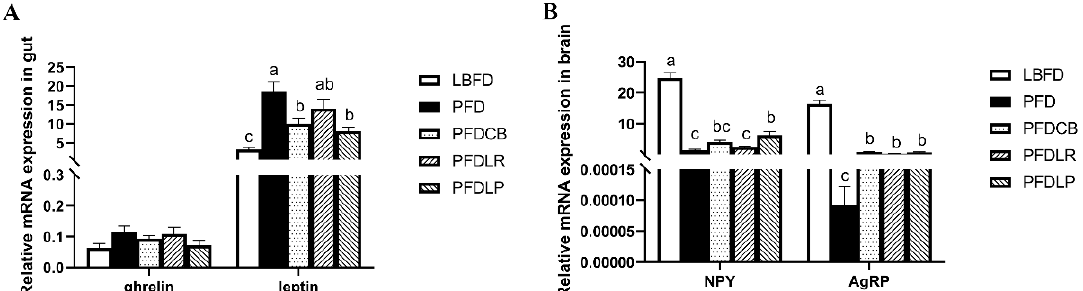
Figure 6. Relative mRNA expressions of appetite control genes in the gut ( A ) and brain ( B ) of mandarin fish in different feeding groups (LBFD, PFD, PFDCB, PFDLR and PFDLP) after being fed for 28 days. Data are presented as mean ± SEM ( n = 9). Abbreviations: NPY, nerve peptide y ; AgRP, agouti gene-related protein ; LBFD, live bait fish feeding group; PFD, pellet-feed feeding group with probiotics free; PFDCB, pellet-feed feeding group with C. butyricum plus; PFDLR, pellet-feed feeding group with L. rhamnosus plus; PFDLP, pellet-feed feeding group with L. plantarum plus. Data are presented as mean ± SEM ( n = 9). A value followed by a lowercase superscript (a–c) differs significantly from all other values not followed by the same lowercase superscript at the same time point based on ANOVA followed by the post hoc test ( p < 0.05).